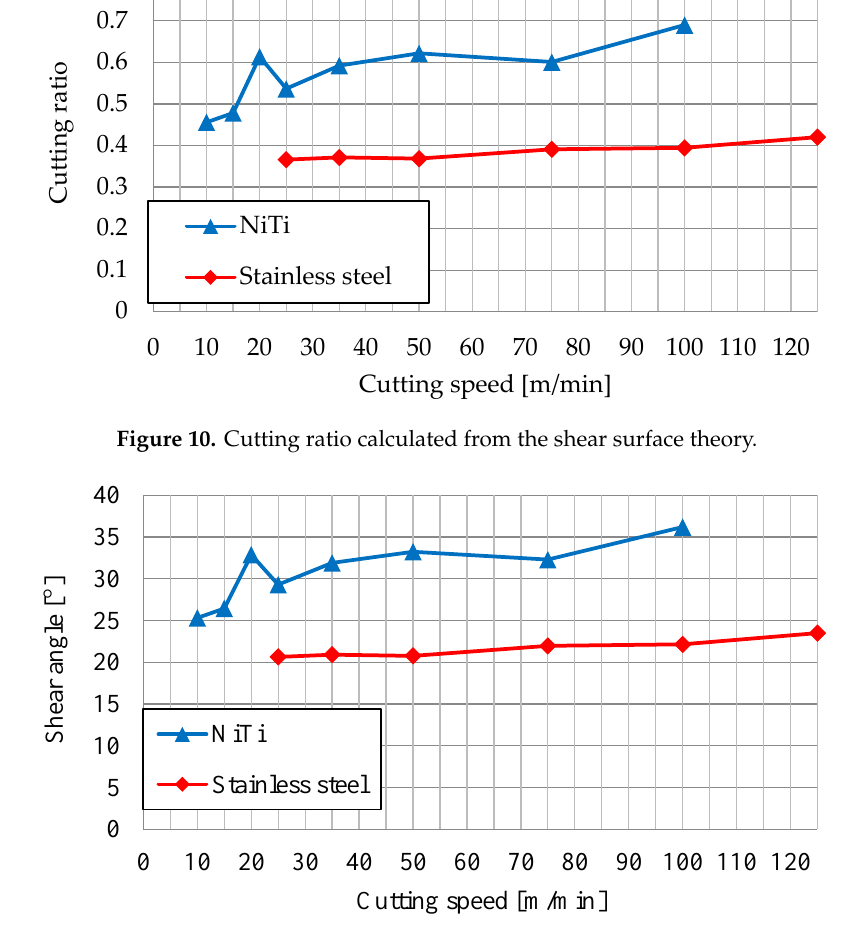
Figure 11. Shear angle calculated from the shear surface theory.